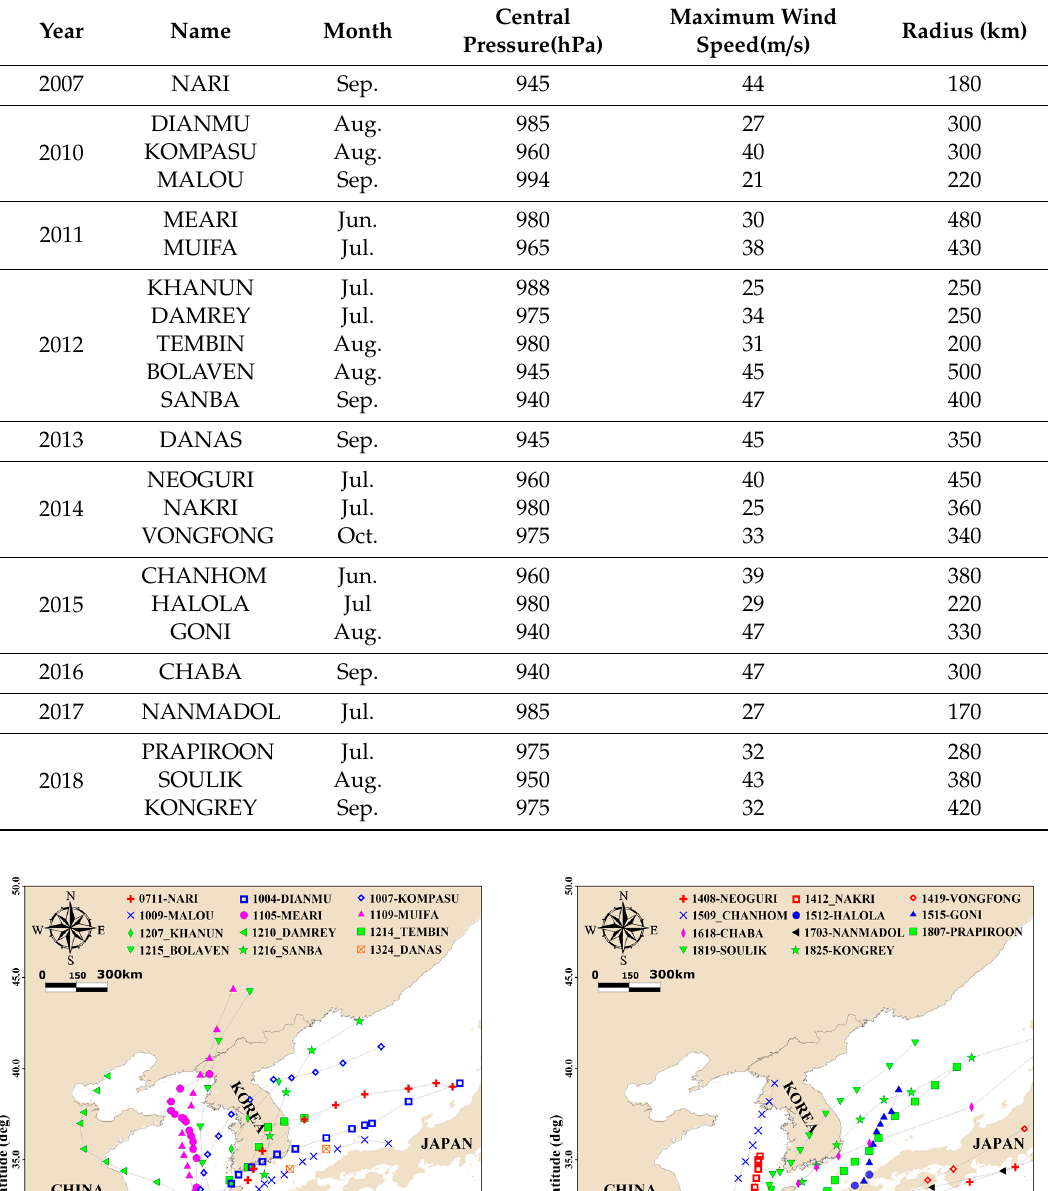
Table 9. List of typhoons that influenced the Korean Peninsula from 2007 to 2018.